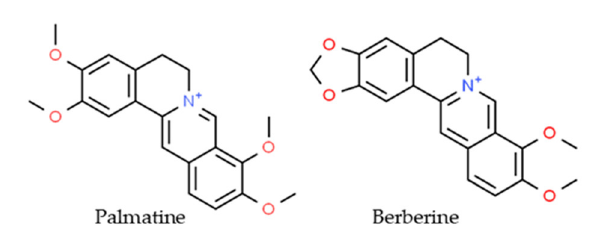
Figure 1. The chemical structure of palmatine and berberine.